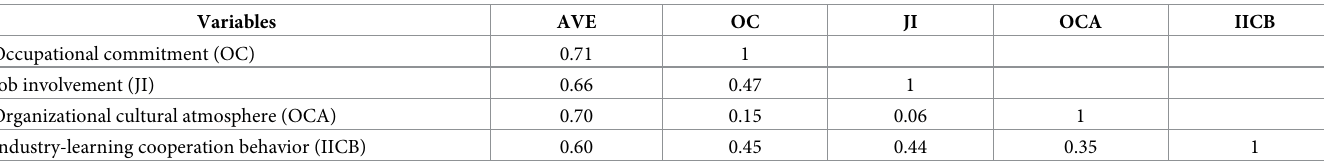
Table 3. Results of variable discrimination